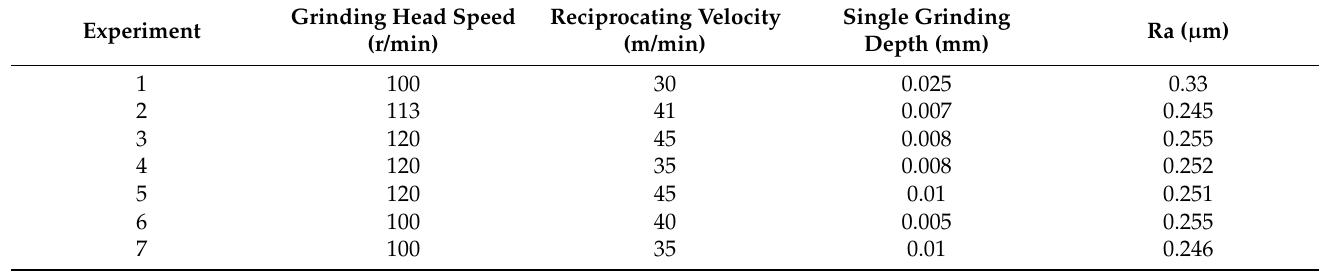
Table 7. Experimental arrangement and measurement results.